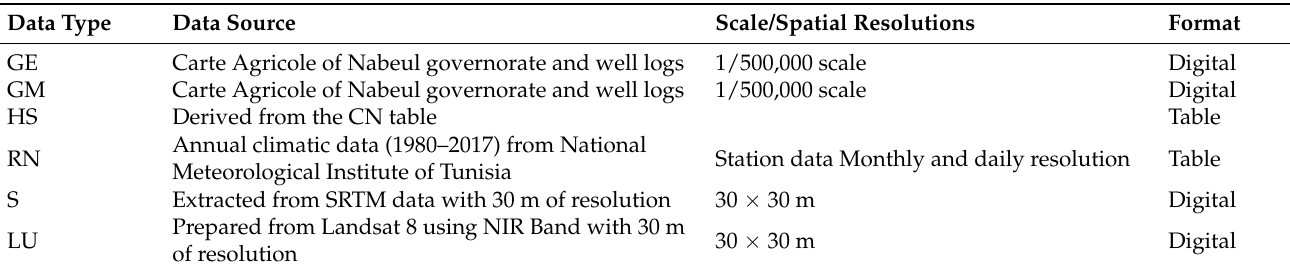
Table 3. Data sources